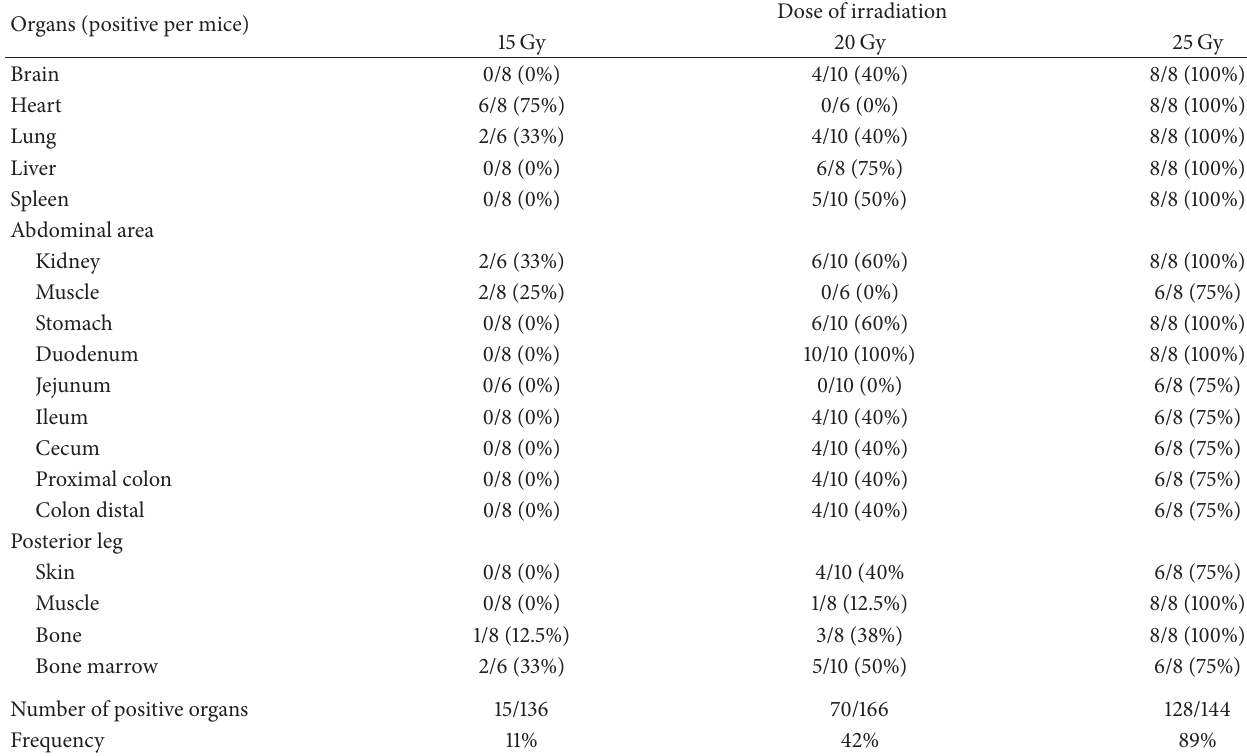
Table 2: hMSC biodistribution in function of the irradiation dose 6 weeks after local irradiation of the right posterior leg at 15 to 25 Gy. Organs (positive per